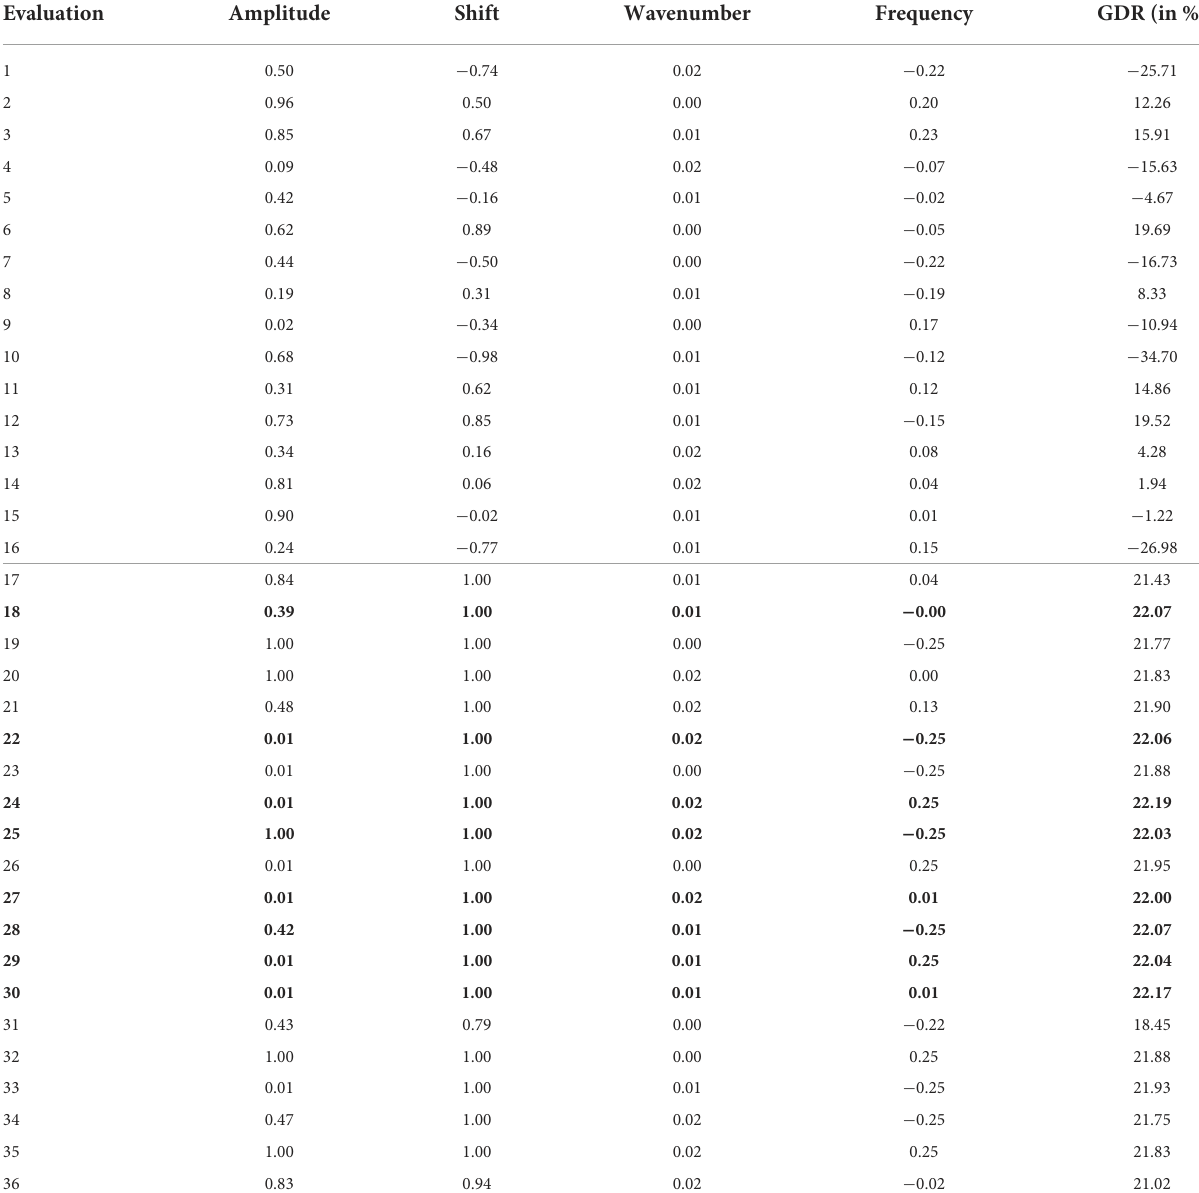
TABLE 7 Results for traveling wave